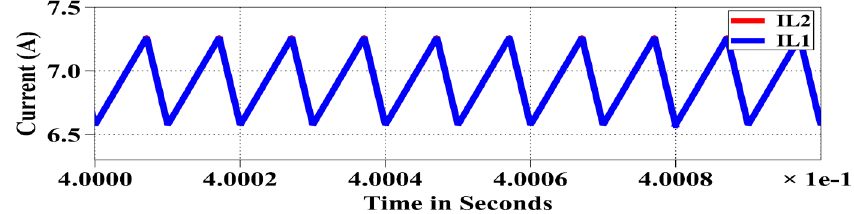
Figure 6. Inductor current waveforms of the converter.